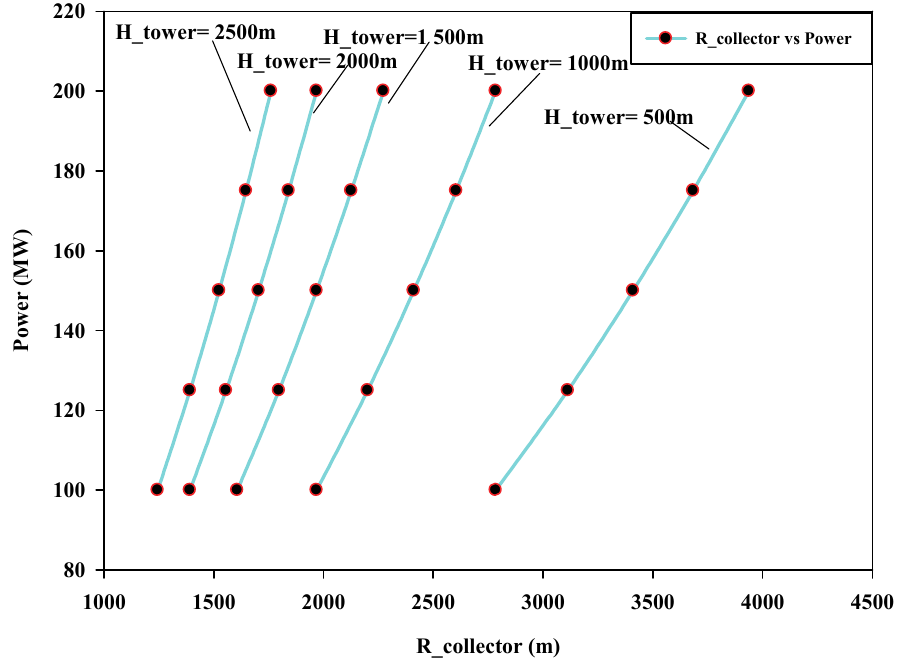
Figure 14. Effect of variation in power output on collector radius ( R Collector ) for different tower heights ( H Tower ) in SUTPP.